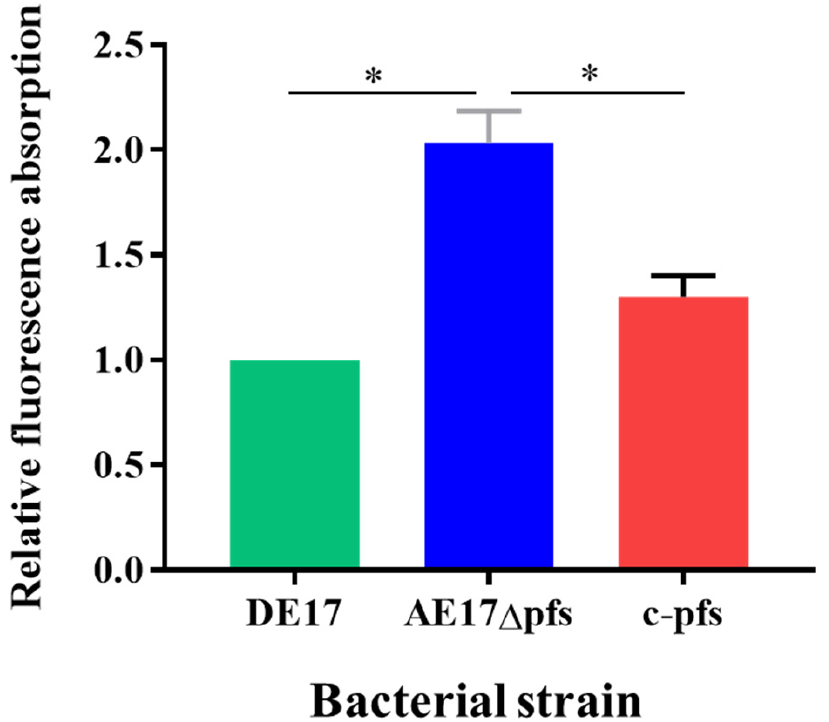
Figure 4. The APEC membrane permeability was determined by measuring the fluorescence resulting from the uptake of 1-N-phenyl-naphthylamine (NPN). The results are presented as the means ± SE of three independent experiments, (ns, not significant; * p < 0.05). According to the analysis of the transcriptome, we used qPCR to detect the transcrip- tion level of β -lactam resistance related genes. The qPCR results revealed changes in the mRNA levels of β -lactam resistance-related genes in APEC following pfs deletion (Figure 5). Compared with the wild-type strain DE17, the selected efflux pump-encoding gene tolC and penicillin-binding protein genes ( fstI and mrcA ) transcription levels were significantly reduced after pfs deletion ( p < 0.05). However, the transcription level of 3 porin protein- encoding genes ( ompF , ompC , and ompD ) increased significantly ( p < 0.05). Compared with the wild strain, the deletion strain was up-regulated 2.5-fold, 1.5-fold, and 3.0-fold, respectively. The transcription levels of these genes were restored in complementary